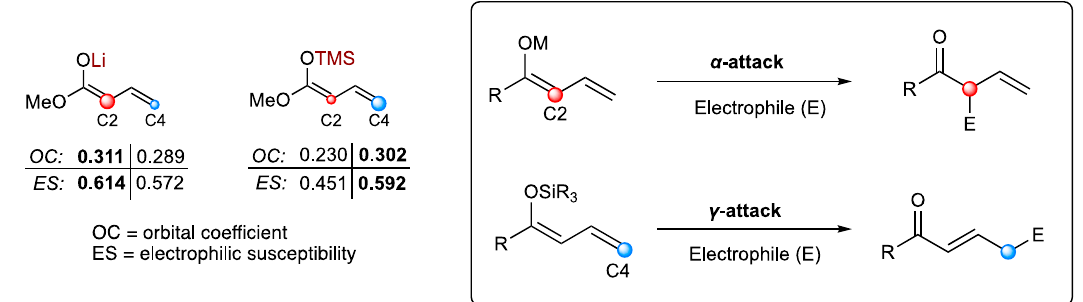
Figure 1. Intrinsic reactivity of different types of dienolates.